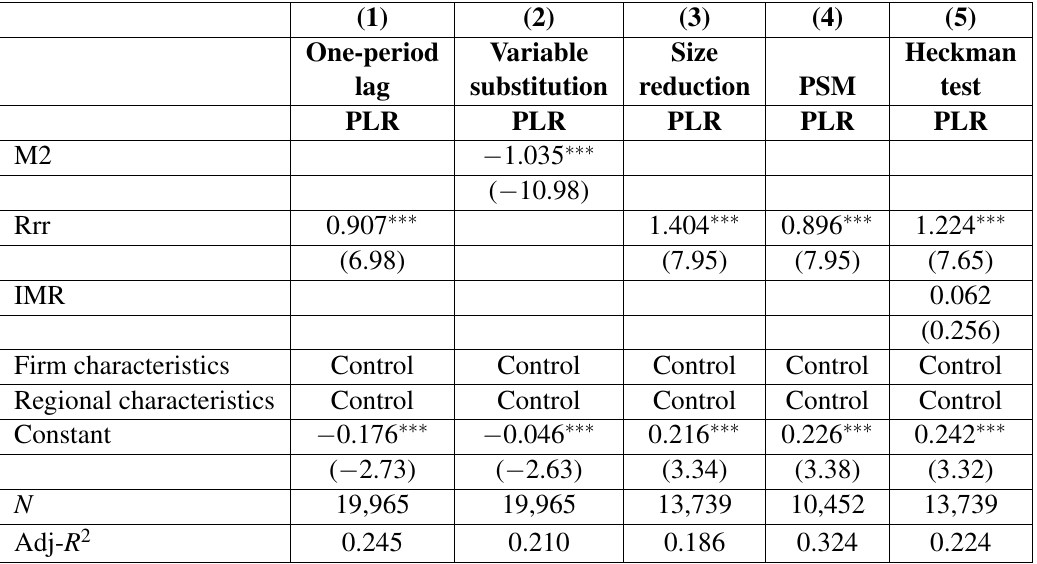
Table 8 Endogenesis and robustness